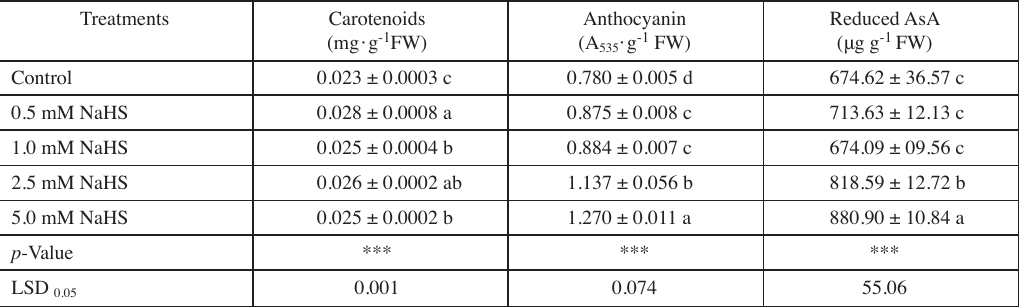
Tab. 2: Effects of different doses of NaHS on carotenoids, anthocyanin and reduced AsA concentration. Treatments